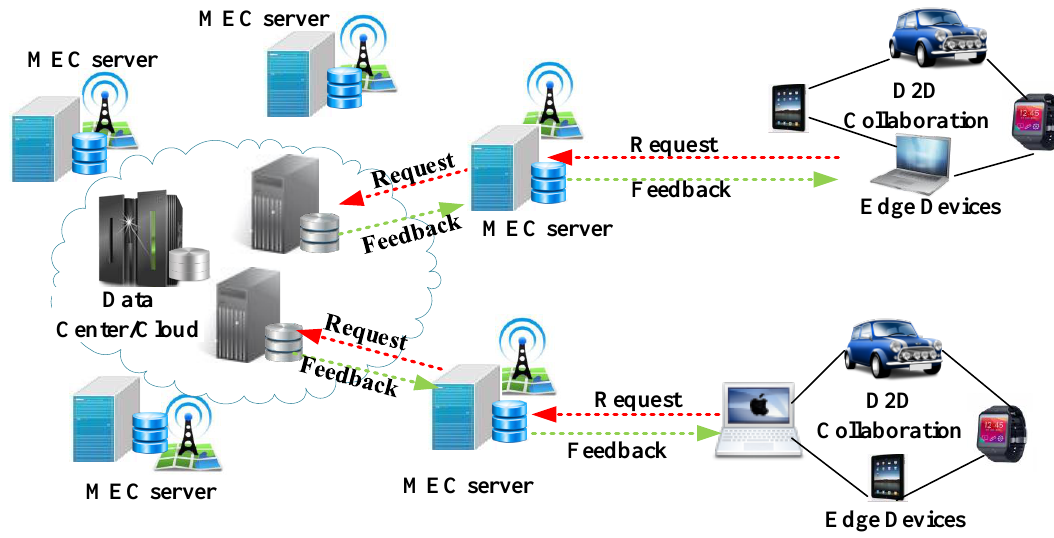
Figure 1. Mobile edge computing